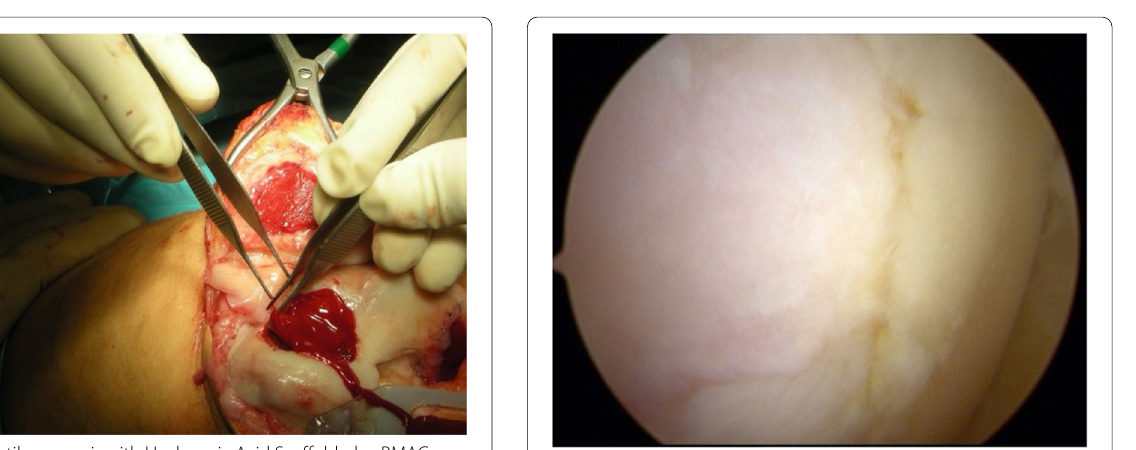
Fig. 11 The arthroscopic view shows the delamination of the previous HA-BMAC scaffold with a size of 38